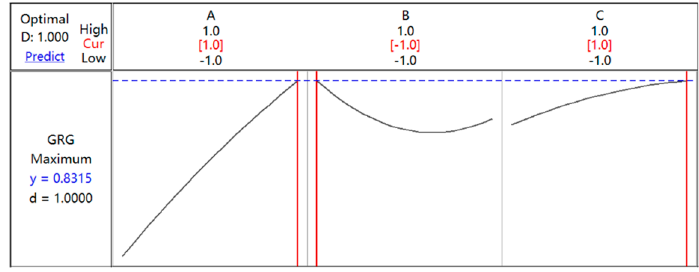
Figure 4. Multi-objective optimization results of cutting parameters.